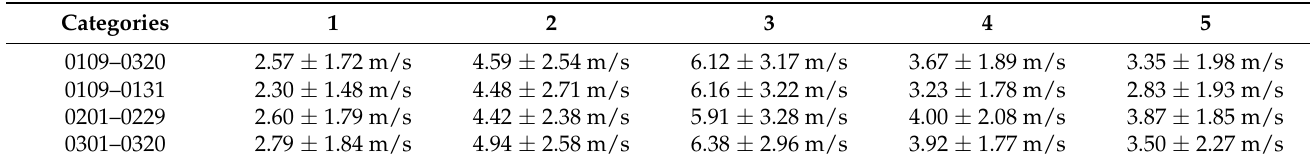
Table 6. The average horizontal wind speed at 10 m above the ground at different atmospheric stabilities at site 1.